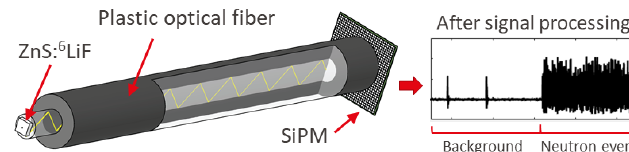
Fig. 6. Schematic of a miniature neutron detector working